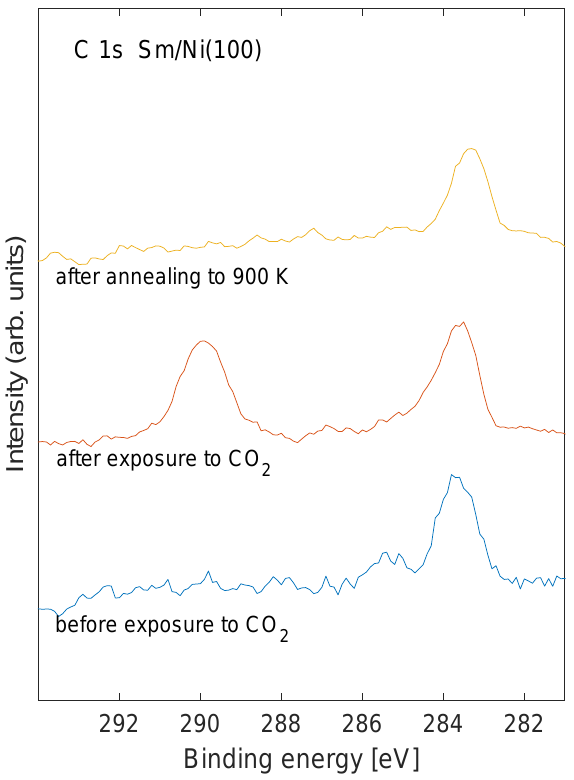
Figure 1. C 1s XPS recorded before exposure to CO 2 ( bottom spectrum ), after exposure to CO 2 ( middle spectrum ), and after annealing to 900 K ( top spectrum ). The Sm coverage was estimated to 0.8 ML.